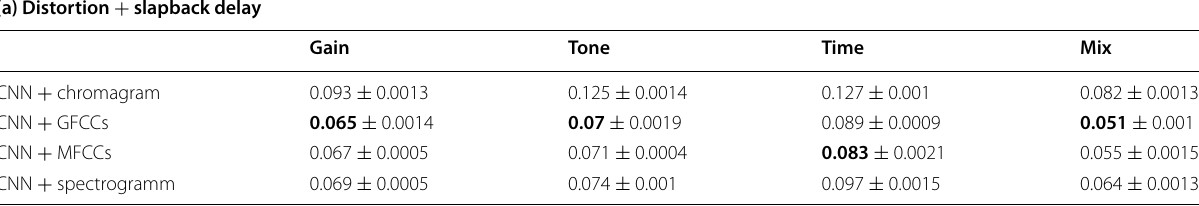
Table 6 95% confidence intervals of the mean absolute error of the CNN across the fivefold cross-validation of the parameter extraction and all volumes. Results are reported for all time-frequency representations and the combination of distortion and slapback